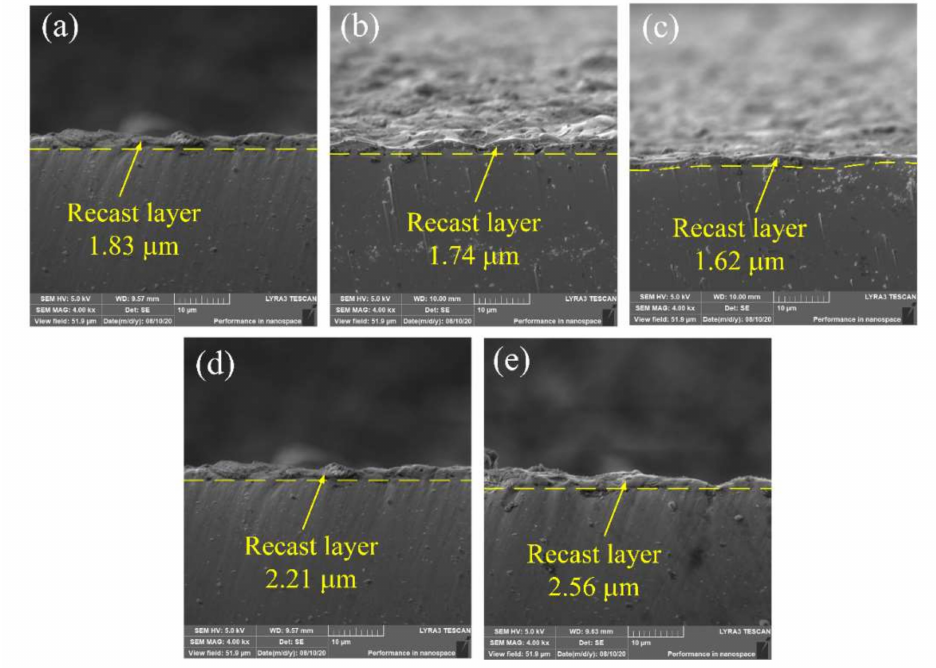
Figure 12. Cross section images of EDM-treated TiNi shape memory alloy (SMA) under the TiC concentrations of ( a ) 0 g / L, ( b ) 3 g / L, ( c ) 5 g / L, ( d ) 7 g / L, and ( e ) 10 g / L.